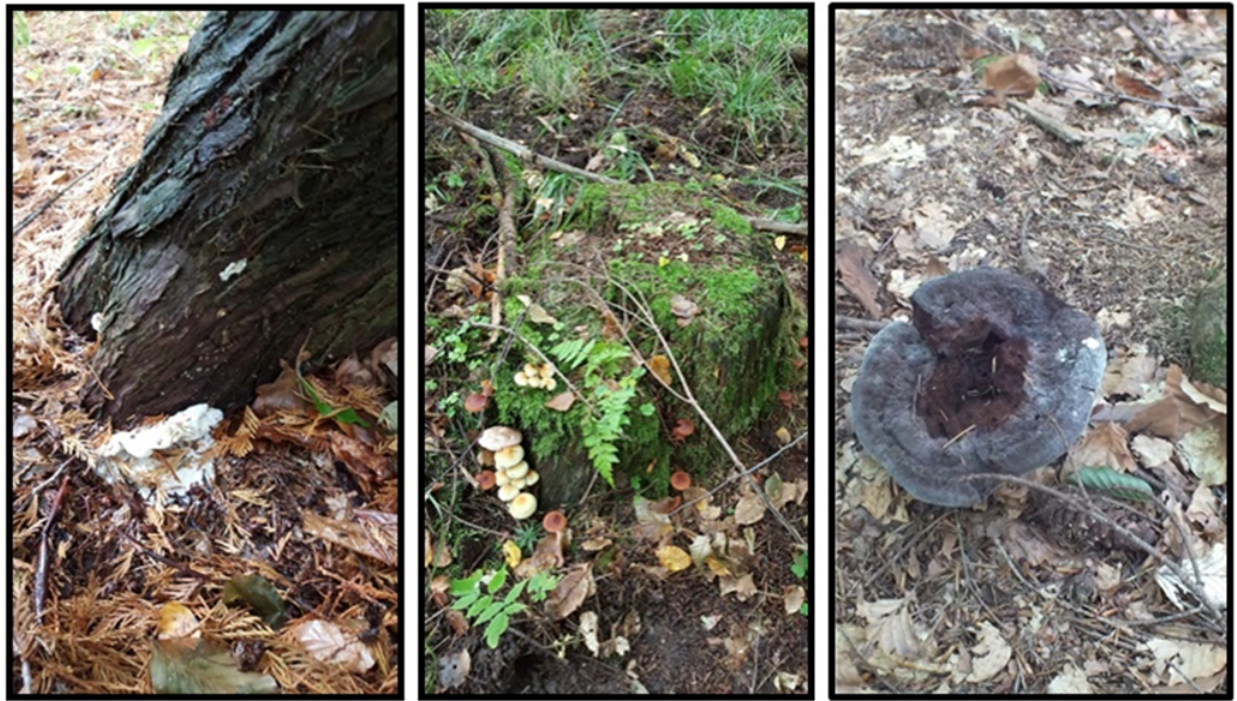
Figure 4 Heterobasidion annosum basidiocarpson the T. plicata root collar (left), Hypholoma fasciculare on P. strobus stump (middle), and Phaeolus schwinitzii on root of Pseudotsuga menziesii